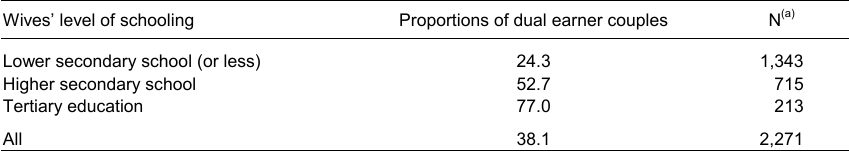
Tab. 3 Proportions of dual-earner couples, aged 18-65, by wives’ level of schooling. Italy 2001. Percentages